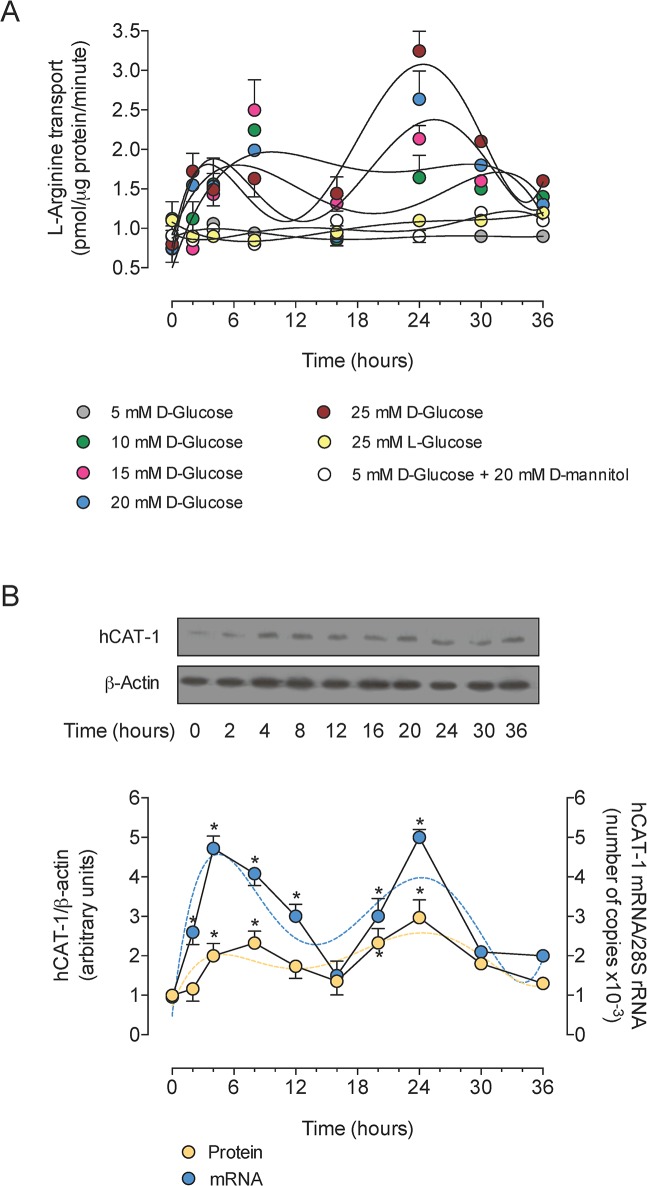
Temporal increase of hCAT-1 expression and activity by high D-glucose.A, Uptake of 100 μmol/L L-arginine (2 μCi/mL L-[3H]arginine, 1 minute, 37°C) in HUVECs preincubated in Krebs solution containing different concentrations of D-glucose, or 5 mmol/L D-glucose + D-mannitol or L-glucose. B, hCAT-1 protein abundance and mRNA expression in 25 mmol/L D-glucose. Western blot is representative of other 10 experiments for hCAT-1 and β-actin (internal reference) proteins. In A lines are the mean values adjusted to a fifth-order polynomial model. In B the segmented lines represent the mean values for protein abundance (light blue) or mRNA expression (yellow) as in A. *P<0.04 versus corresponding values at 0 hours. Values are mean ± S.E.M. (n = 5–10).